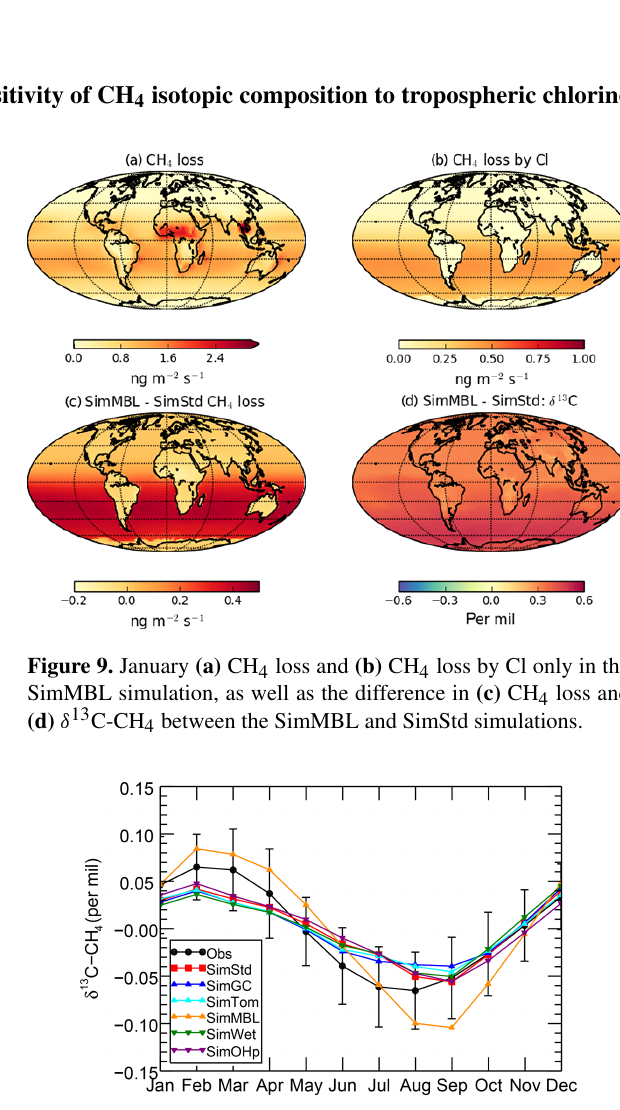
Figure 8. January (a) CH 4 loss and (b) CH 4 loss by Cl only in the SimTom simulation, as well as the difference in (c) CH 4 loss and (d) δ 13 C-CH 4 between the SimTom and SimStd simulations.